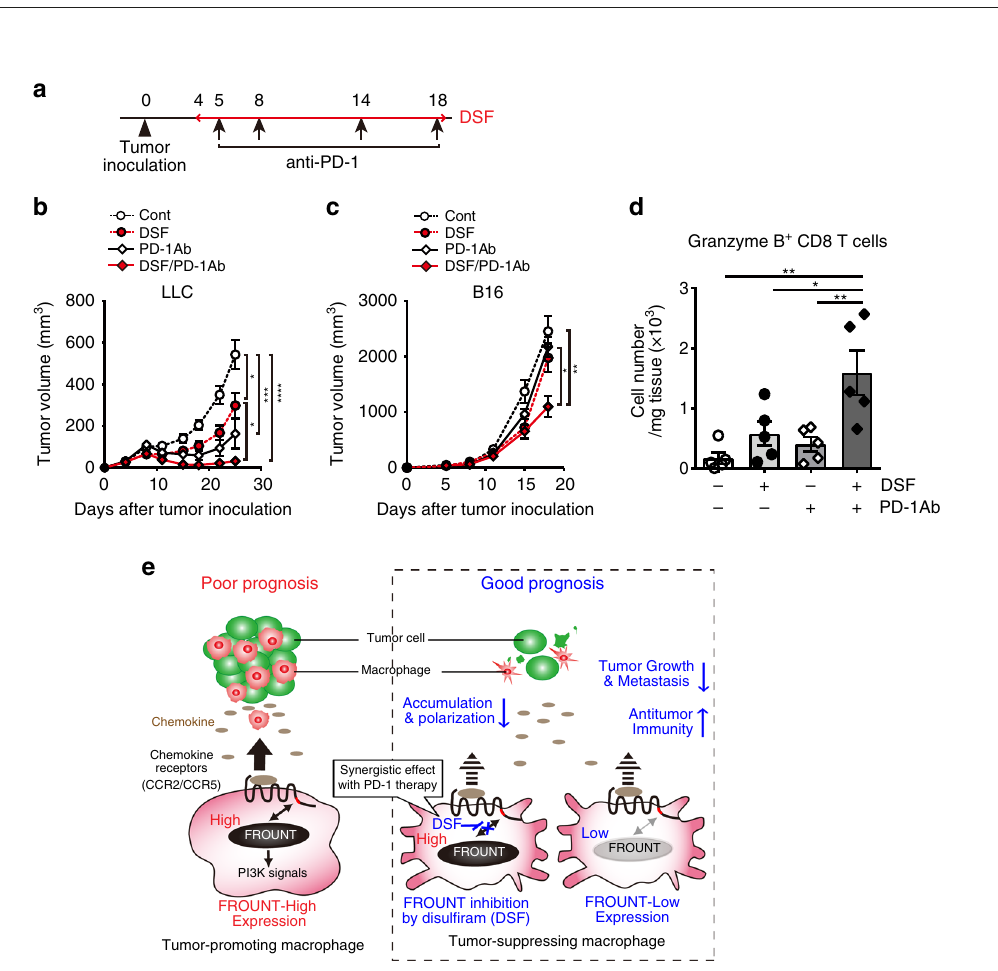
Fig. 8 Synergism between disul fi ram (DSF) and immune-checkpoint blockade. a – d Effects of combination treatment with DSF and immune-checkpoint inhibitor anti-PD-1 antibody on subcutaneous LLC ( b ) and B16 ( c ) tumor growth ( n = 9). d The number of Granzyme B + CD8 + T cells at day 20 post inoculation, detected by fl ow cytometry ( n = 5). e Scheme illustrating the mechanisms by which cytoplasmic protein FROUNT modulates tumor-associated macrophages. The experiment was repeated three times. * P < 0.05, ** P < 0.01, *** P < 0.001, **** P < 0.0001 by one-way ANOVA with Tukey ’ s multiple comparison test. Error bars indicate